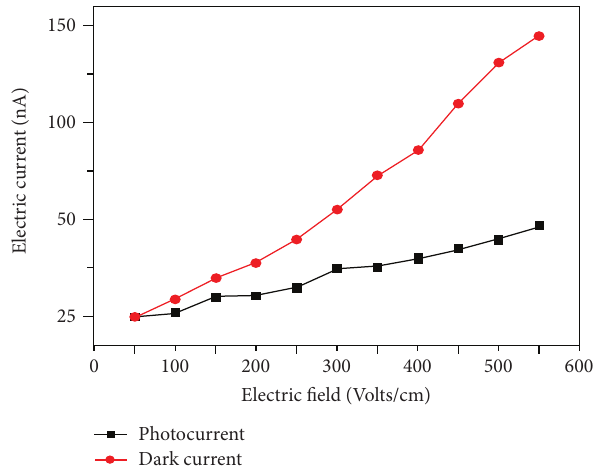
F 5: Field-dependent conductivity of LPBA single